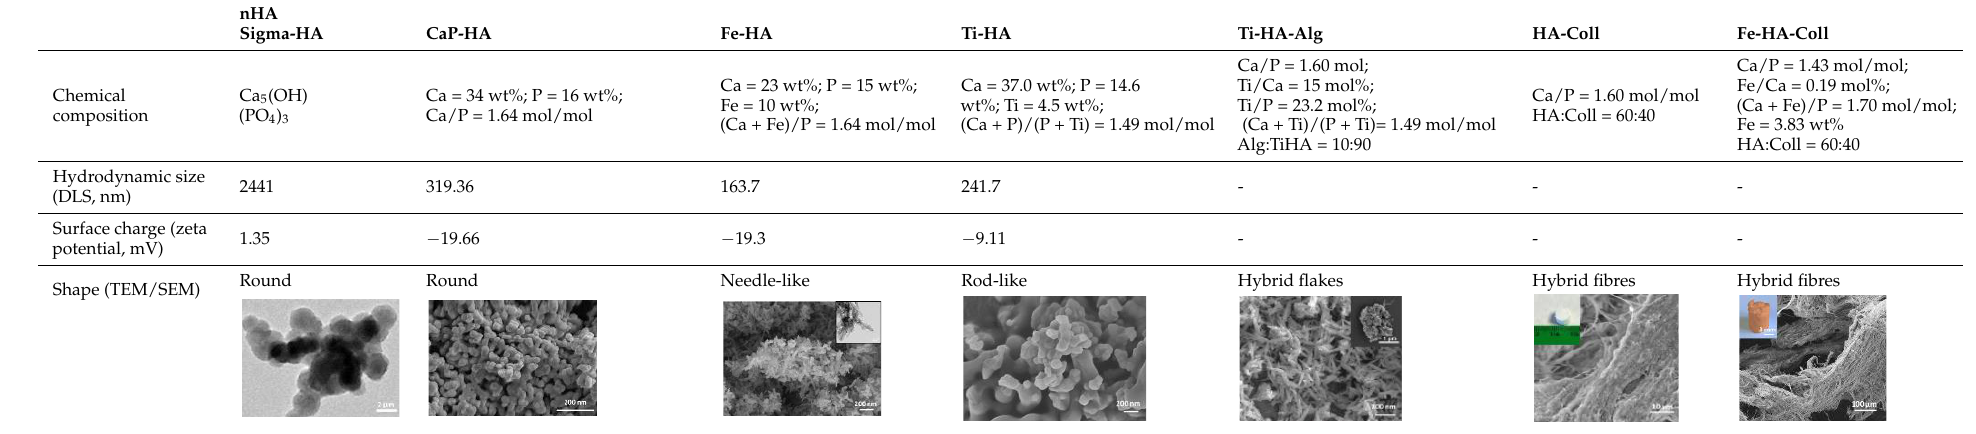
Table 2. A summary of the tested nHA (commercial hydroxyapatite (Sigma-HA), calcium hydroxyapatite (CaP-HA), superparamagnetic iron doped hydroxyapatite (Fe-HA), and titanium-doped hydroxyapatite nanoparticles (Ti-HA), alginate/titanium-doped hydroxyapatite hybrid particles (Ti-HA-Alg), collagen/hydroxyapatite hybrid scaffold (HA-Coll) and collagen/iron-doped hydroxyapatite hybrid scaffold (Fe-HA-Coll)) main characteristics, including chemical composition, hydrodynamic size, surface charge and shape based on TEM/SEM pictures. DLS: dynamic light scattering, TEM: transmission electron microscopy, SEM: scanning electron microscopy.